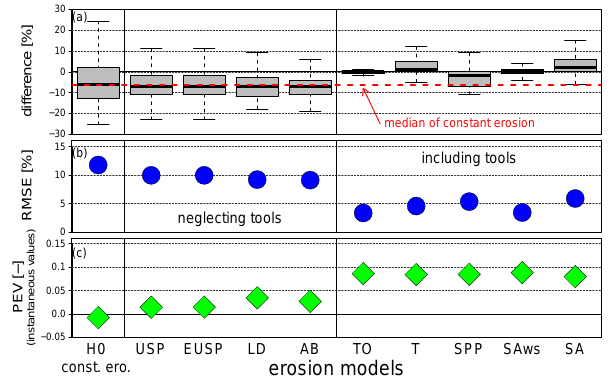
Figure 3. Comparison of individual model performance for the event period: (a) prediction differences from the course of bedrock erosion c3i, (b) root mean square errors RMSE and (c) proportion of explained variances PEV (calculated for the instantaneous erosion values). For model denotations, see Table